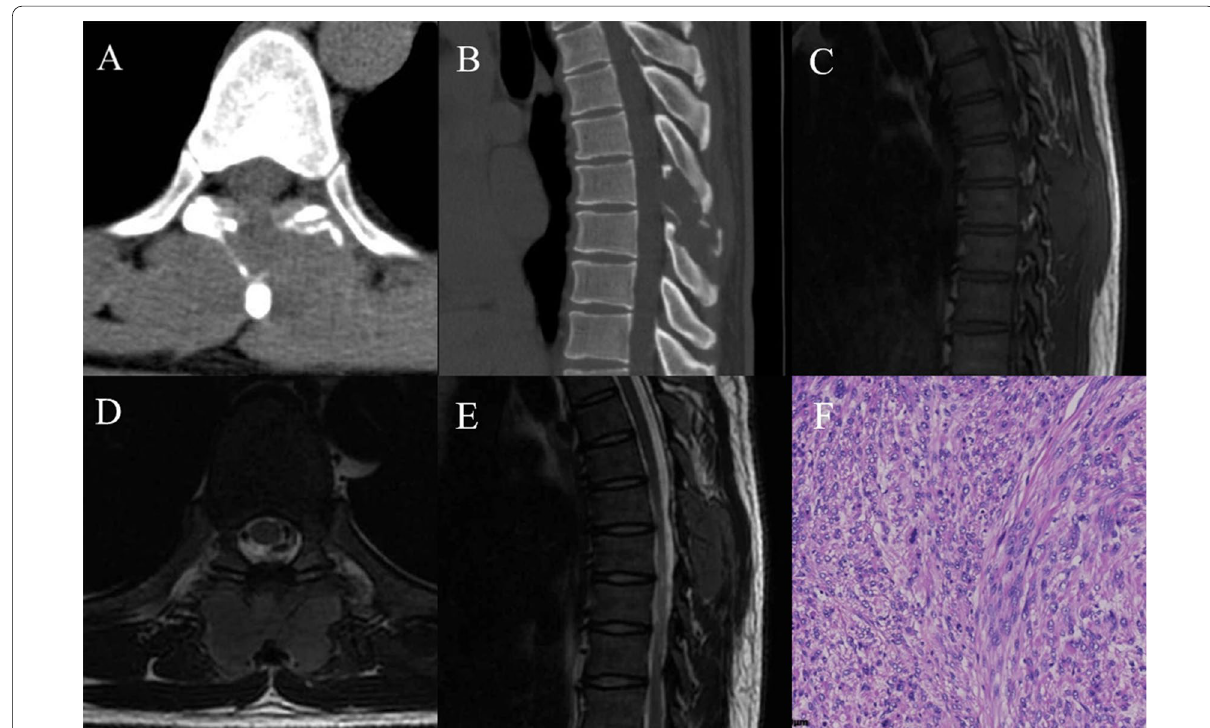
Fig. 4 A 30-year-old male with T7–T8 primary leiomyosarcoma. A Axial computed tomography (CT) showed an ill-defined isodense mass in the posterior elements of T7–T8; B Sagittal CT bone window showed bone destruction in the posterior elements of T7–T8; C T1 weighted